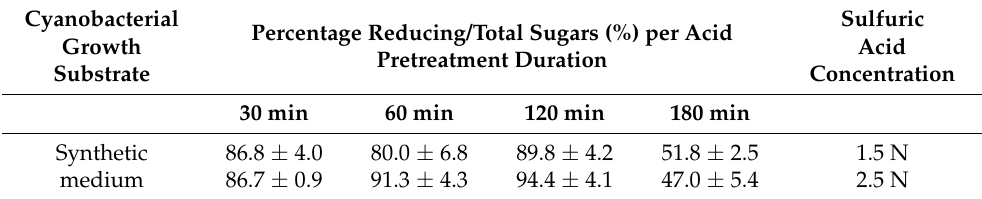
Table 2. Sugar yields obtained from acid pretreatment of biomass for autotrophic microbial culture.